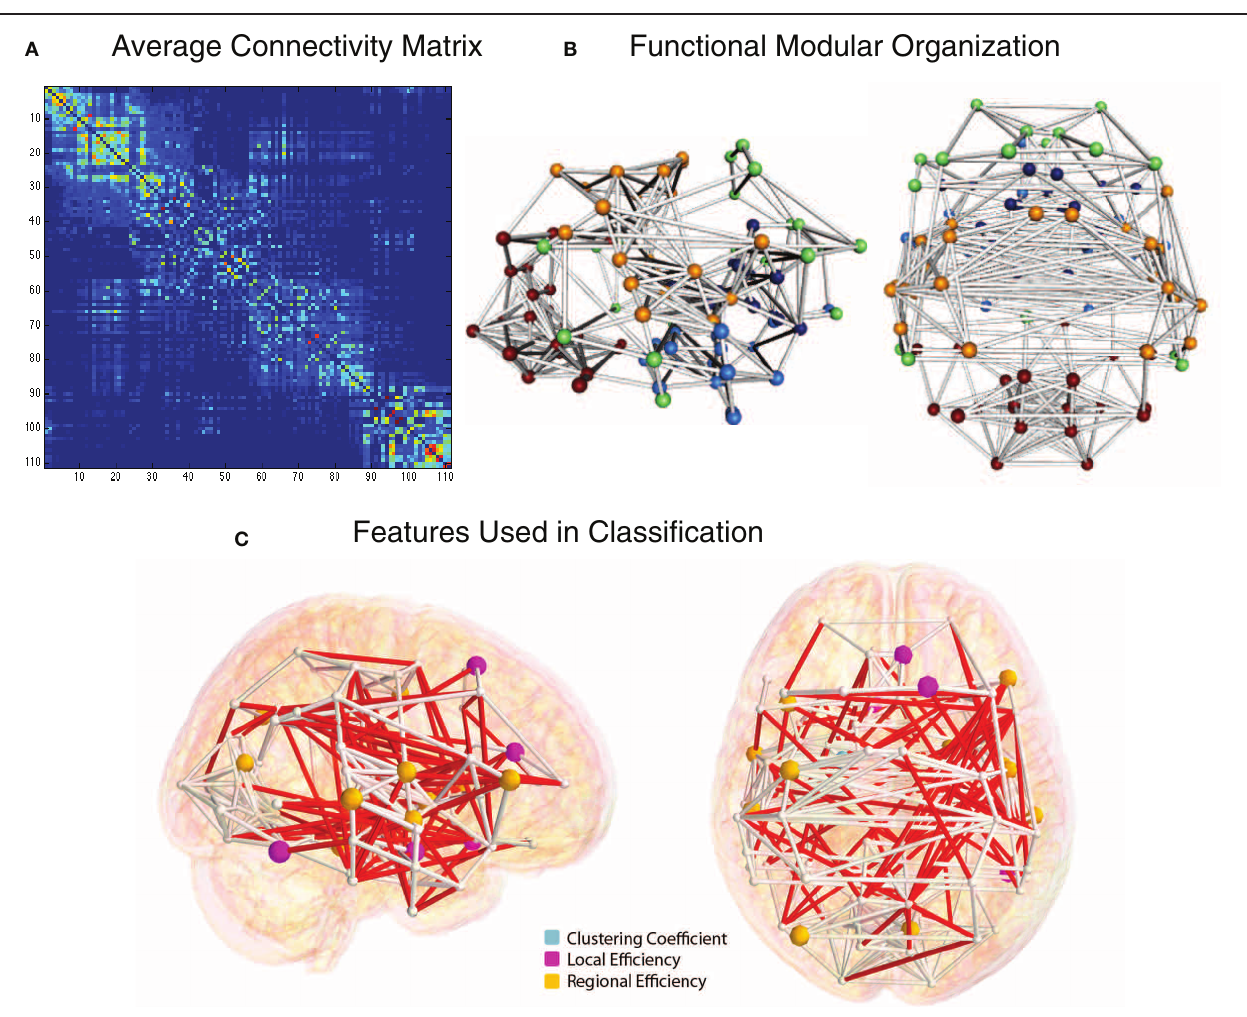
and white cylinders correspond to connections in the top 2% of functional connectivity strength, based on Pearson correlation. (C) Nodes whose graph theory-based measures were used to classify ADHD vs. TD are shown in light blue (clustering coefficient), magenta (local efficiency), and yellow (regional efficiency). Edges whose connection weights were used in the classification are shown in